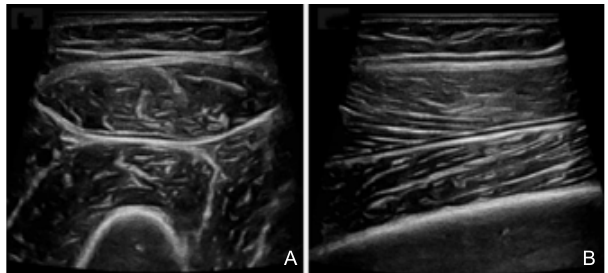
Figure 1 Ultrasound image of the rectus femoris muscle in healthy people. (A) Transverse section; (B) Longitudinal